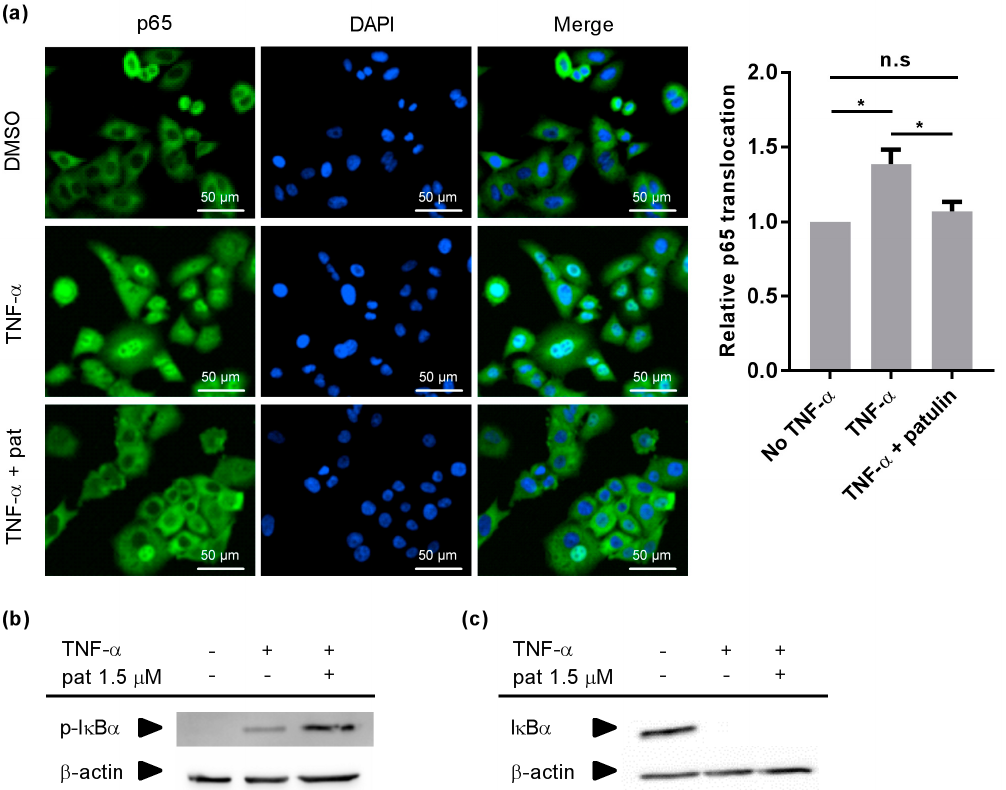
Figure 2 . Patulin inhibited TNF- α -induced p65 nuclear translocation without acting on I κ B α phosphorylation or degradation. ( a ) NF- κ B p65 immunocytochemical translocation pattern in A549 cells following 30 min incubation with either DMSO, 20 ng/mL TNF- α or TNF- α + 1.5 µ M patulin